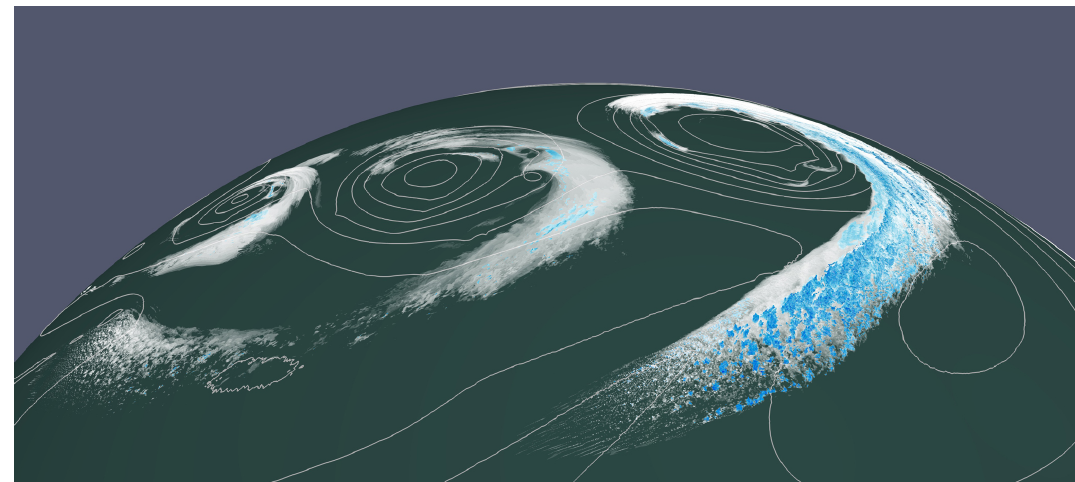
Figure 1. Visualization of a baroclinic wave at day 10 of a simulation with 930m grid spacing. White shading: volume rendering of cloud ice, cloud water, and graupel ≥ 10 − 3 gkg − 1 . Blue shading: isosurface of rain and snow hydrometeors ≥ 4 × 10 − 2 gkg − 1 . The white contours denote surface